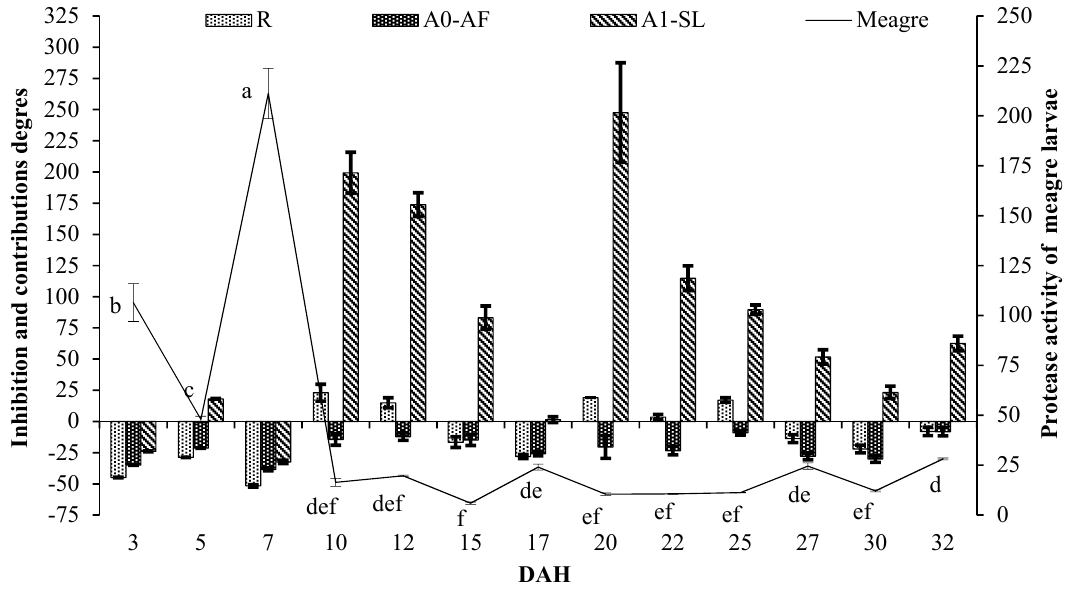
Figure 2. Protease activities of meagre larvae (U/mg protein, mean ± SE) ( p < 0.05) and inhibitions and contributions of live foods on protease activities of meagre larvae in 2013 (%, mean ± SE). Line—larva protease and bar—live food inhibition and